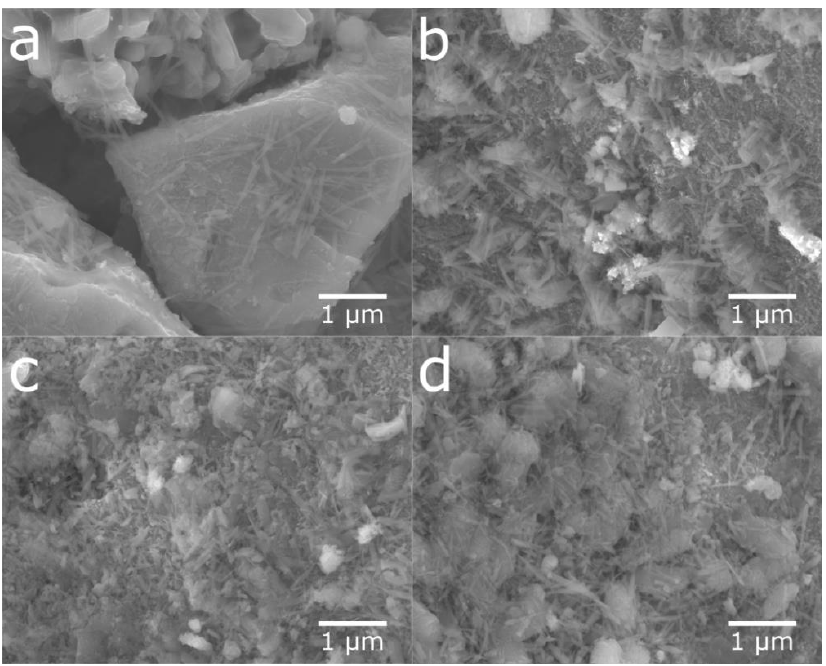
Figure 15. SEM secondary electron images at 20,000 times magnification. Hot KOH treatment of cycled metal hydride (MH) material: ( a ) t = 0, ( b ) t = 3 min, ( c ) t = 10 min, and ( d ) t = 20 min.